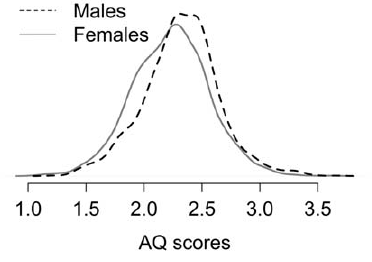
Figure 11. The distribution of mean responses for males and females for the AQ. The distributions are drawn using a Gaussian kernel estimation method (the R default).